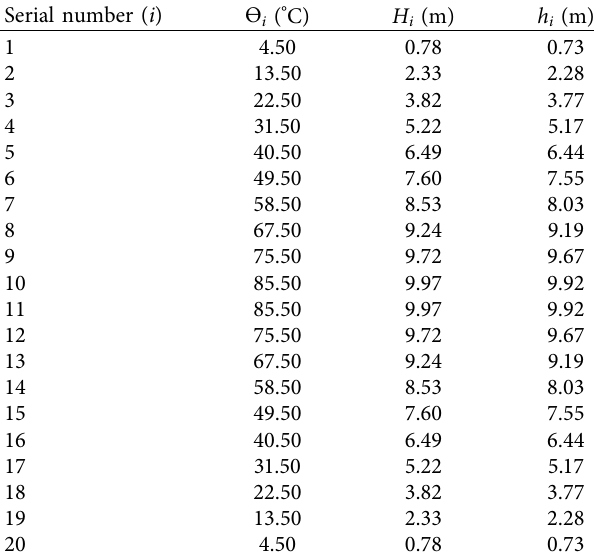
Table 4: Computed values for nonzero staircase modulation scheme.